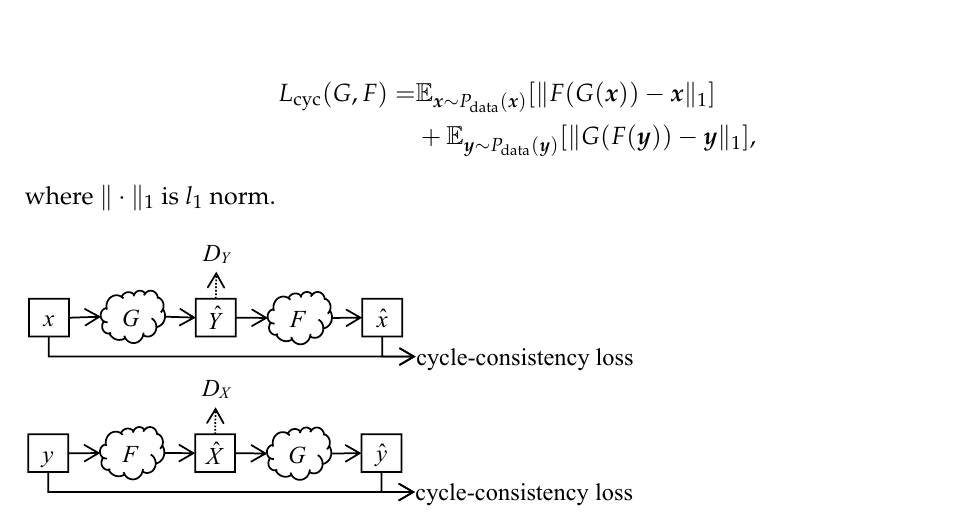
Figure 2. The framework of CycleGAN. It consists of two generative networks and two discriminative networks. G is a converter from domain X to Y , and F is the reverse. The cycle-consistency loss monitors whether the data are distorted in the transformation of X - Y - X and Y - X - Y